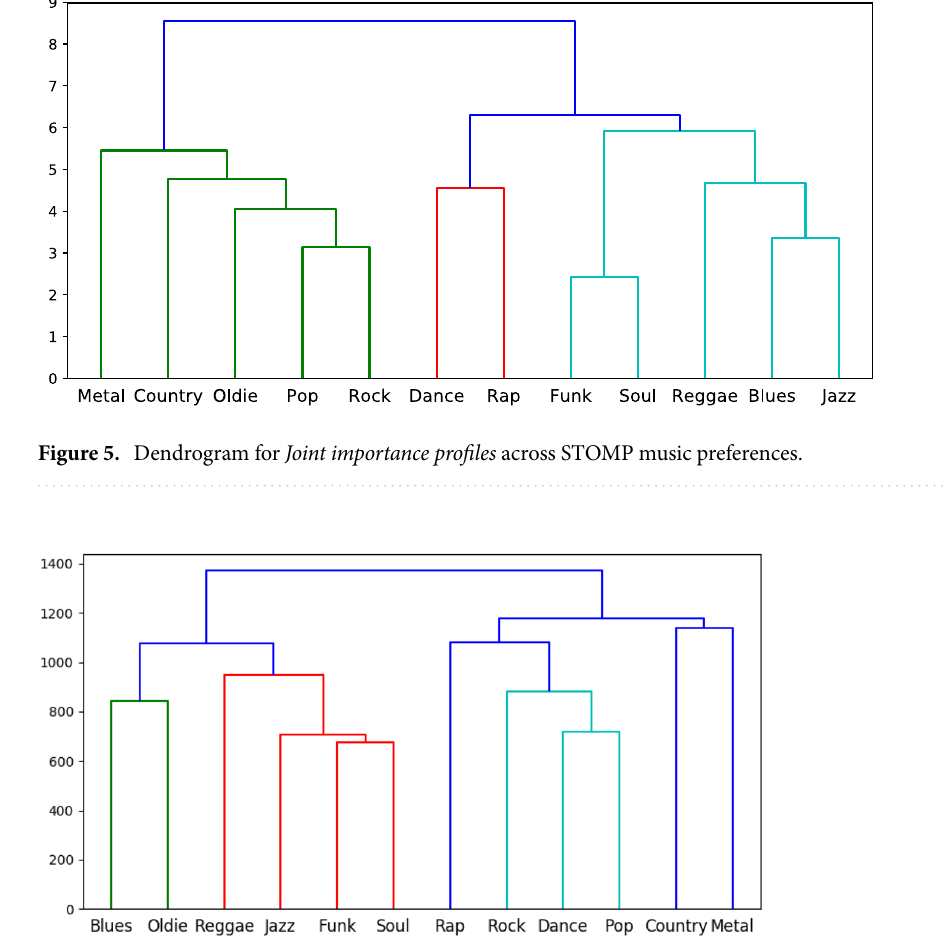
Figure 6. Dendrogram of the self-reported ratings for STOMP music